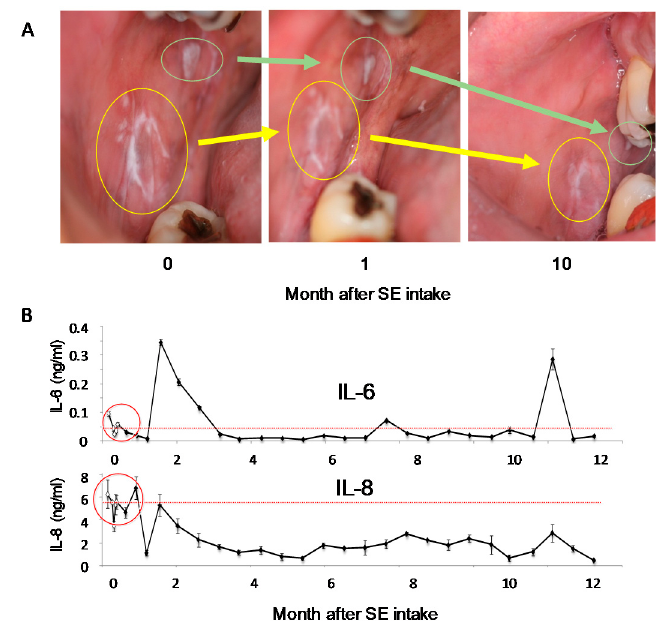
Figure 10. Effect of SE treatment on the oral lichenoid dysplasia. ( A ) Oral inspection with a digital camera, ( B ) salivary IL-6 and IL-8 concentrations. Cited from Reference [107] with permission.